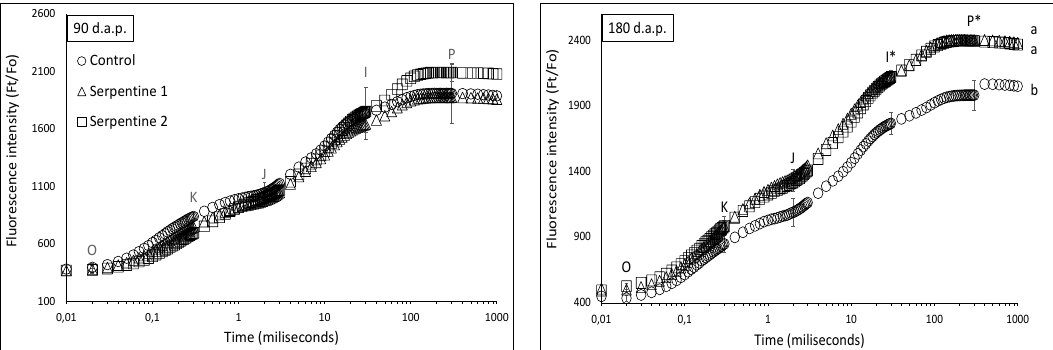
Figure 3. B. radula seedlings (90 d.a.p.) from Serpentine 2 ( left ) and control ( right ).